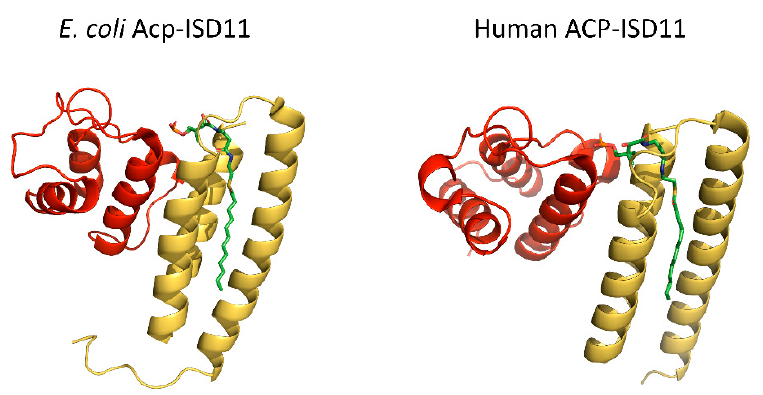
Figure 4. The ACP–ISD11 heterodimer. Comparison of E. coli Acp–ISD11 from SDAUF Cryo-EM structure (6NZU, [21], left ) and human ACP–ISD11 heterodimer crystal structure (6ODD, [34], right ). Both structures contain a long acyl chain (green) attached to ACP (red) that interacts with the ISD11 (yellow) hydrophobic core.